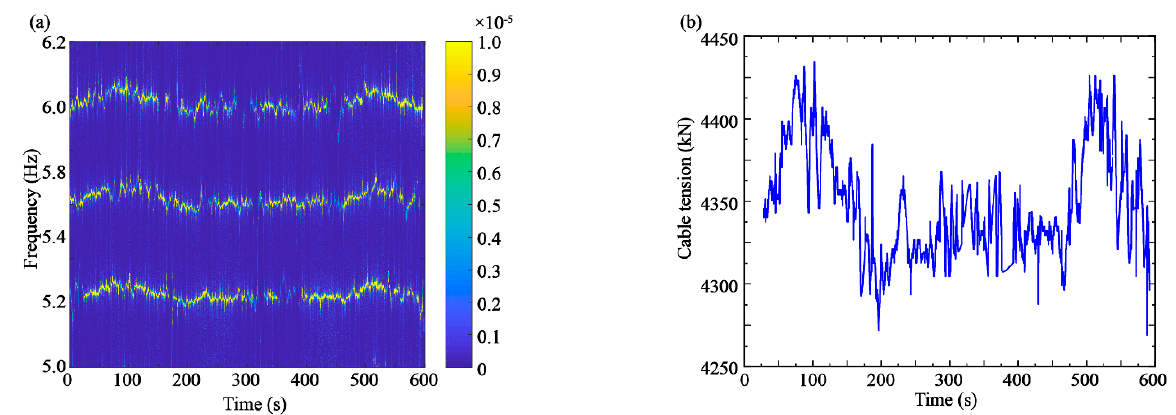
Figure 16. ( a ) TFR spectrogram of measured acceleration responses and ( b ) identified cable tension using 15th frequency.